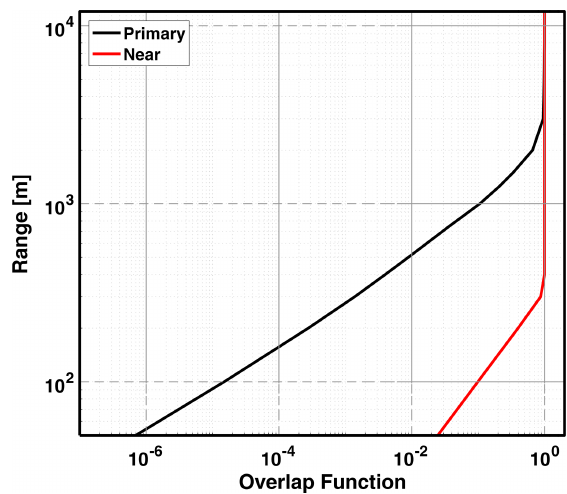
Figure B1. Overlap function for the primary and near/WFOV re- ceivers.